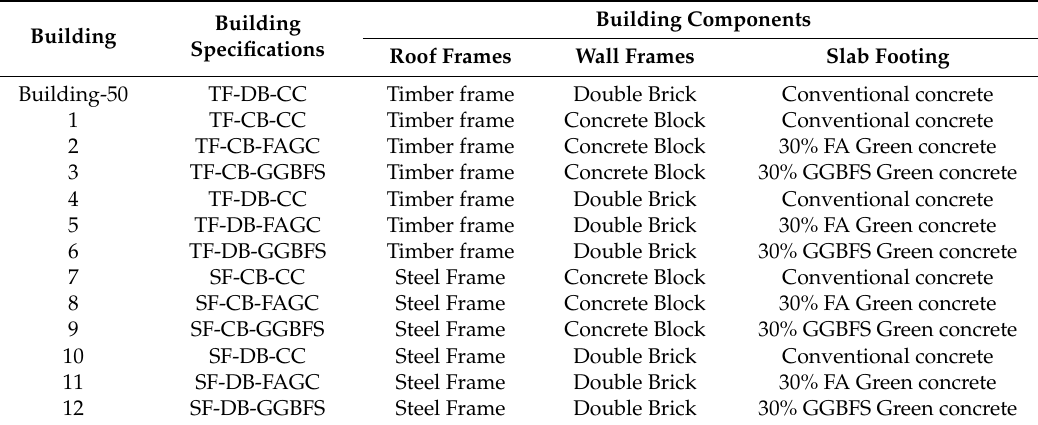
Table 2. Building components of building combinations and the reference